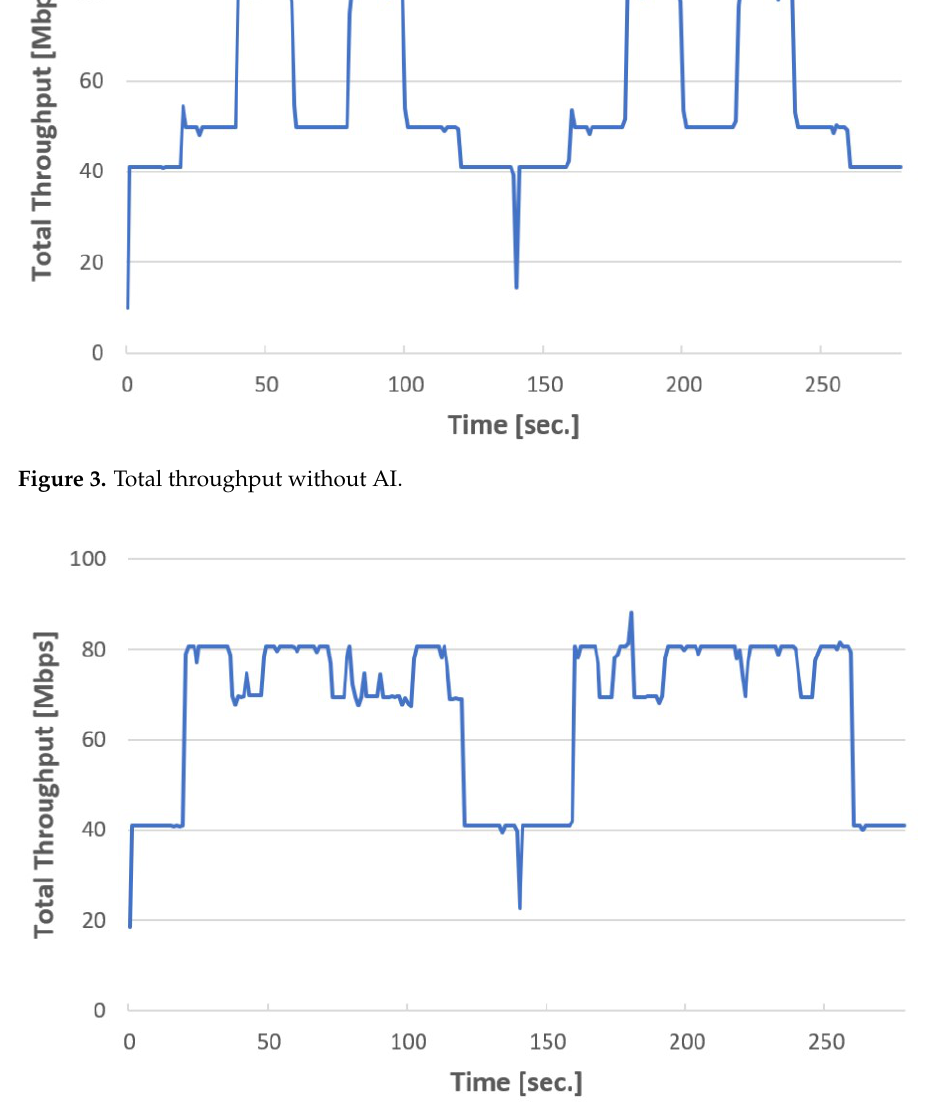
Figure 4. Total throughput with